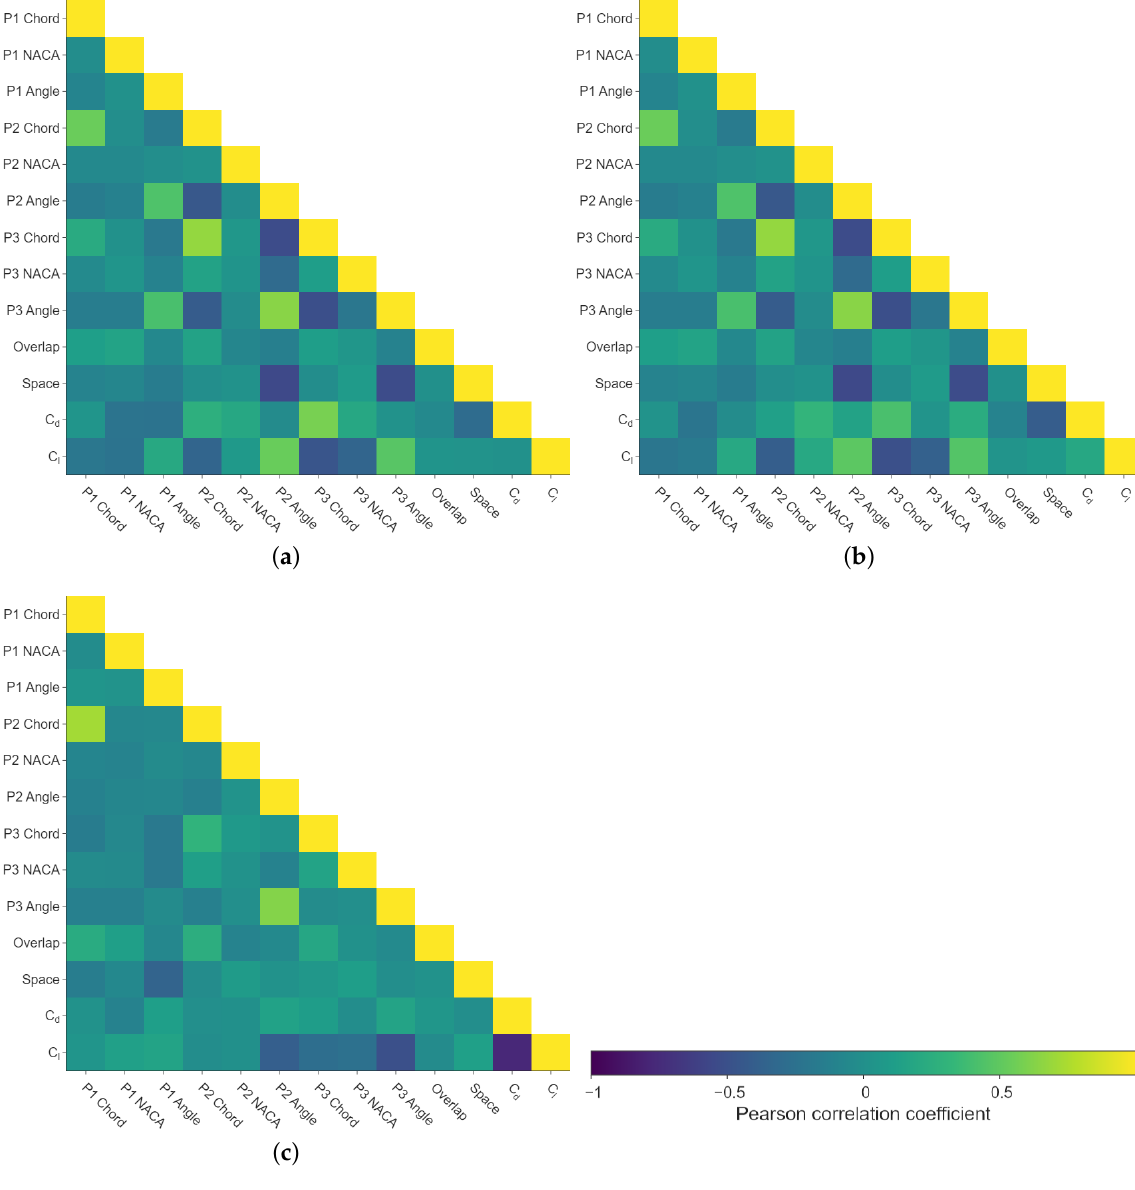
Figure 5. Parameter exploration via Pearson correlation for ( a ) A-A cross-section (400 mm), ( b ) B-B cross-section (670 mm), and ( c ) C-C cross-section (940 mm), of the five-element front wings from the specified input design variable